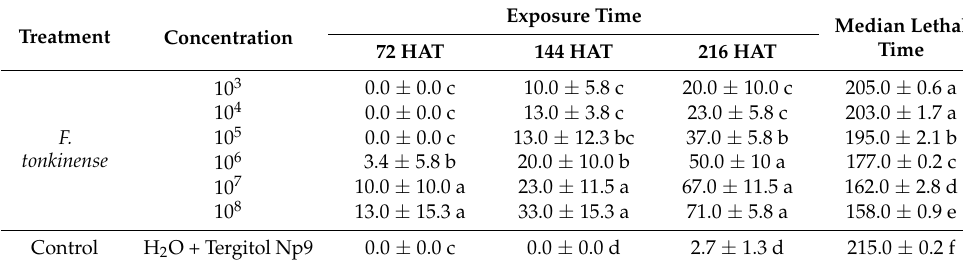
Table 5. Mean mortality ( ± sd) and Median Lethal Time of H. armigera adults exposed to F. tonkinense for 216 h of two season experiments. Means of the same column followed by the same letter are not significantly different (Tukey test, a = 0.05), Median Lethal Time (hours ± sd) was estimated by the Kaplan–Meier method (F = 3.893, df = 6, p < 0.001), HAT: Hours After